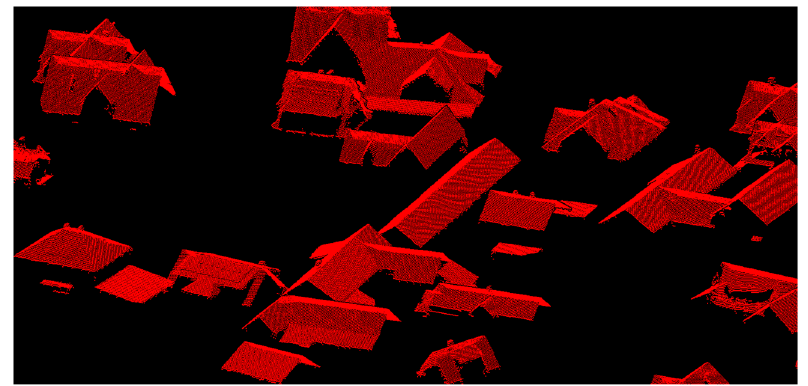
Figure 13. Classified point cloud from the L1 scanner.